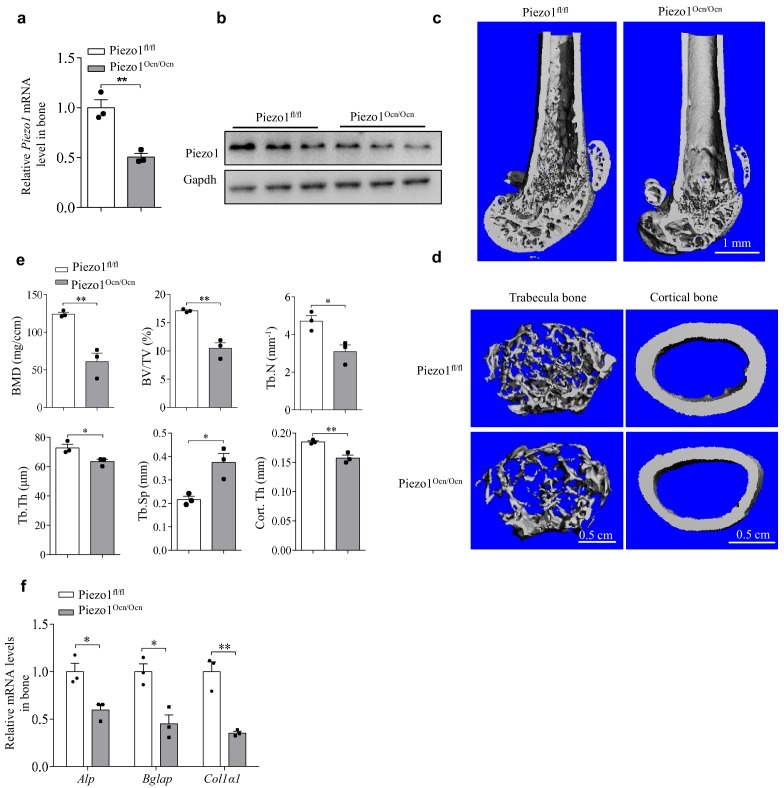
The phenotypes of female Piezo1fl/fl and Piezo1Ocn/Ocn mice.(a) QRT-PCR analysis of Piezo1 mRNA level in bone tissue from Piezo1fl/fl or Piezo1Ocn/Ocn female mice at 2 months. (b) Western blot analysis of Piezo1 protein level in bone tissue from Piezo1fl/fl and Piezo1Ocn/Ocn female mice at 2 months. (c, d) Representative images showing three-dimensional cortical bone and trabecular architecture as determined by micro-CT reconstruction at the distal femurs of Piezo1fl/fl or Piezo1 Ocn/Ocn female mice at 2 months old. Scale bars: 1.0 mm (c), 0.5 mm (d). (e) Micro-CT measurements for BMD, BV/TV, Tb.N, Tb.Th, Tb.Sp and Cort.Th in the distal femurs of Piezo1fl/fl or Piezo1Ocn/Ocn female mice. (f) QRT-PCR analysis of Alp, Bglap and Col1α1 mRNA levels in bone tissues collected from Piezo1fl/fl and Piezo1Ocn/Ocn female mice. Each group, n = 3. All data are the mean ± s.e.m. *, p<0.05; **, p<0.01.